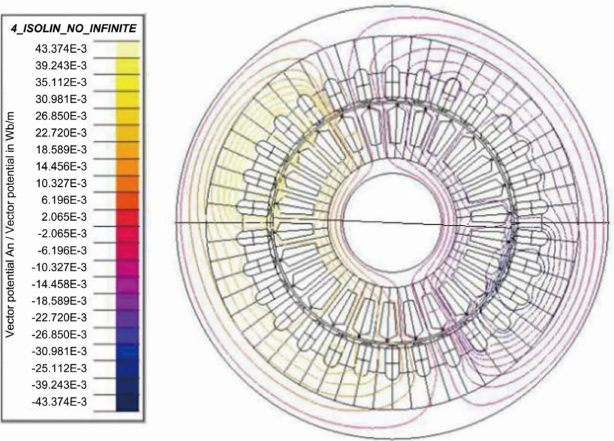
Figure 12. The distribution nephogram of magnetic lines during normal operation of the motor.